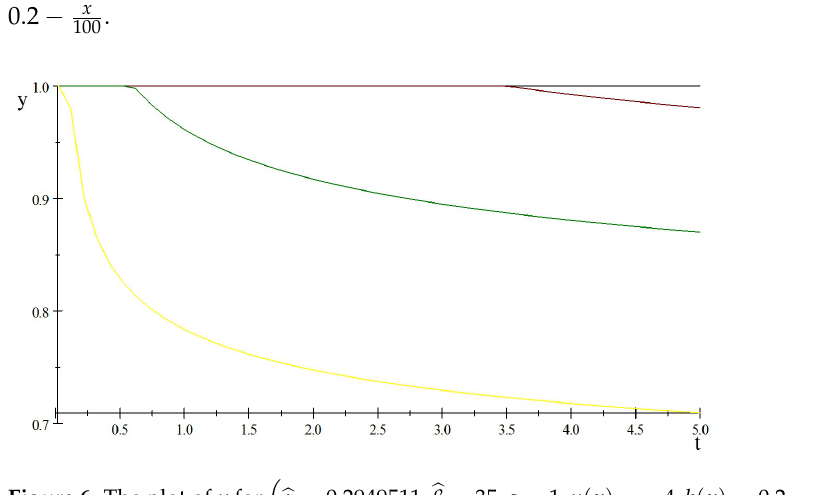
Figure 6. The plot of y for